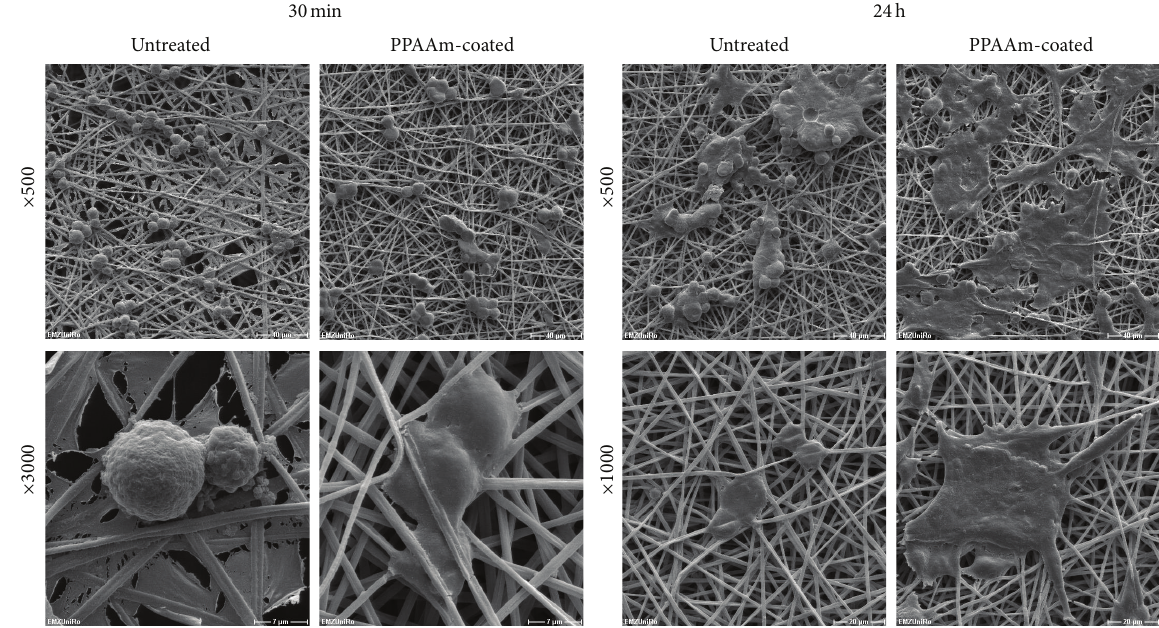
Figure 7: SEM images showing spreading of SV40-HUC-1 uroepithelial cells on untreated and PPAAm-coated PLA fiber meshes after 0.5 and 24h (bar = 40 𝜇 m (upper row), 20 𝜇 m (lower row, right images), and 7 𝜇 m (lower row, left images)).